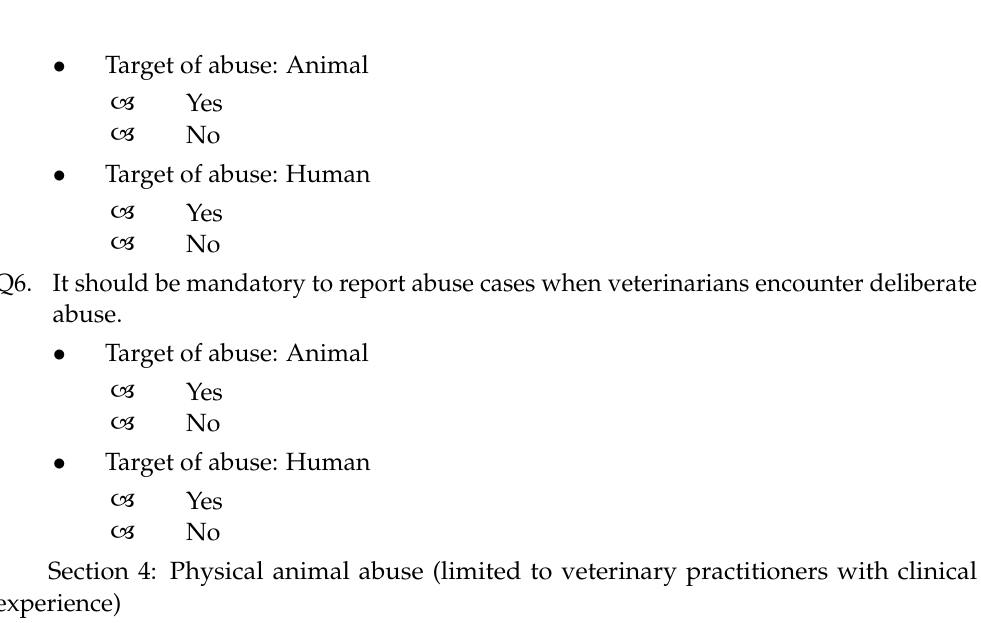
Section 4: Physical animal abuse (limited to veterinary practitioners with clinical ex-